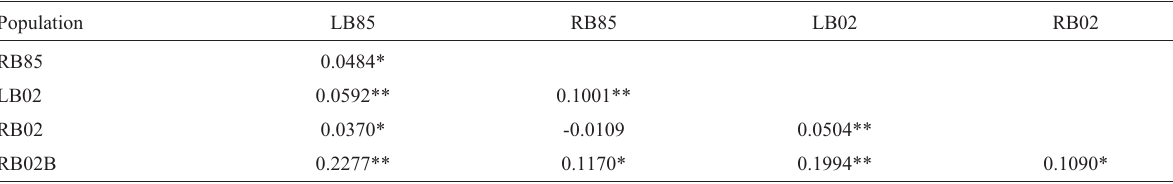
Table 4 - Matrix of Rst values for pairwise comparisons between A. belzebul populations from Tucuruí. Population